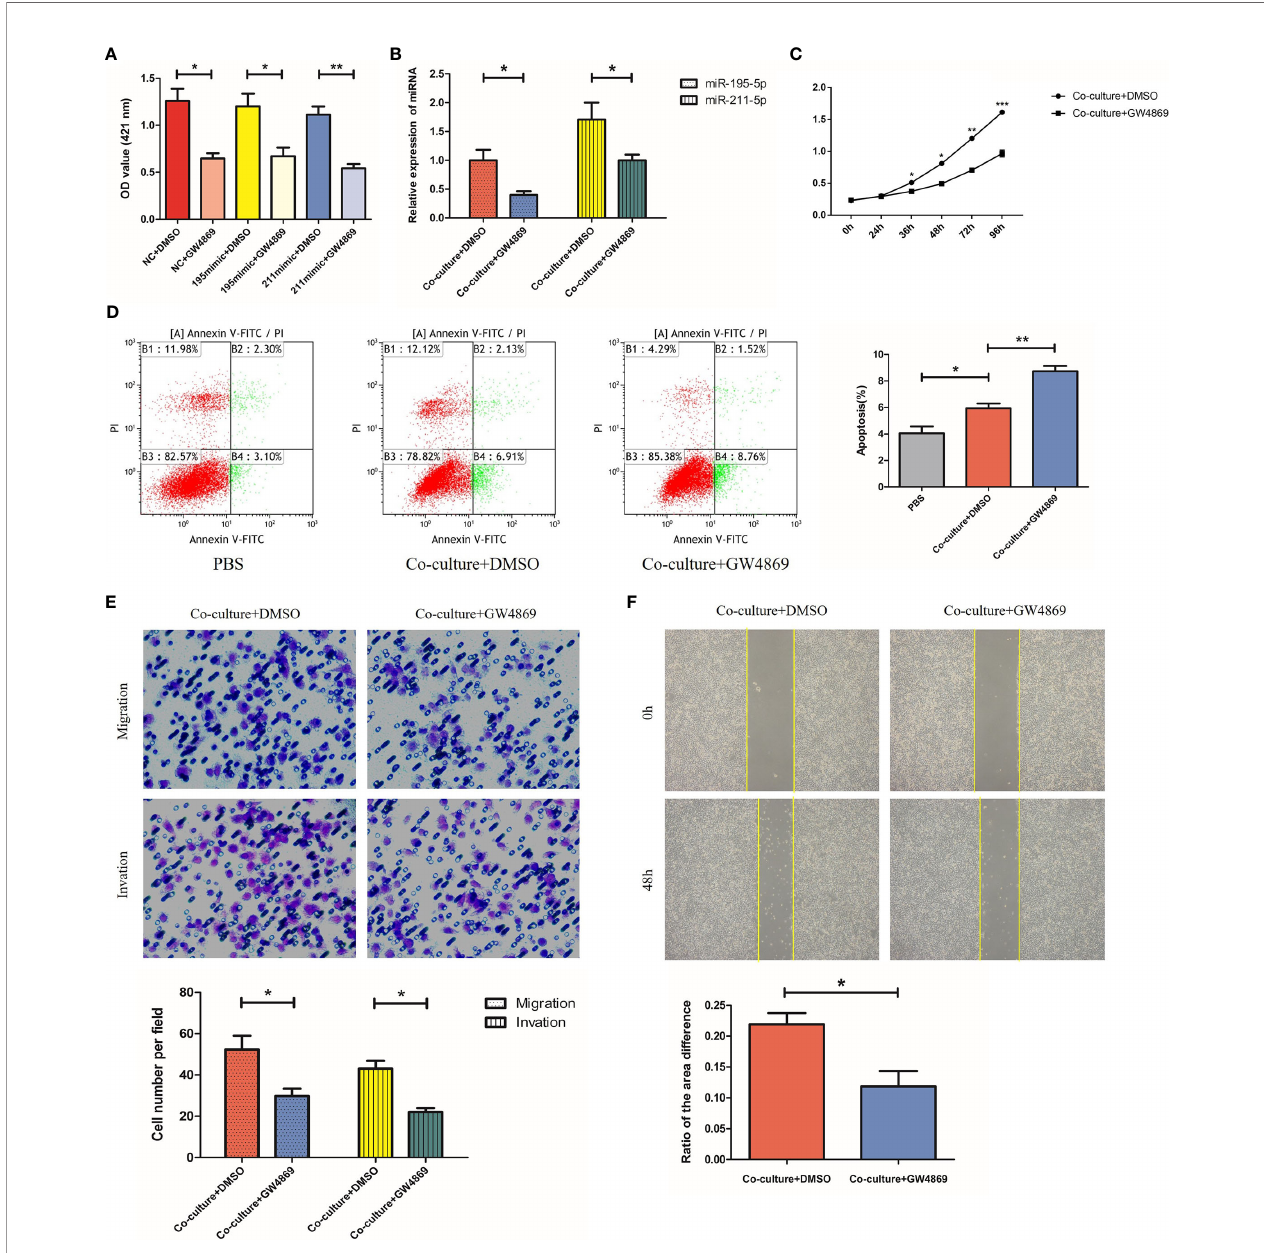
FIGURE 5 | GW4869 inhibits secretion of exosomes from SGC-7901 cells. (A) Release of exosomes from SGC-7901 cells in cells treated with GW4869 or DMSO detected using Ach E activity assay; (B) MiR-195-5p and miR-211-5p expression in 7901 cells treated with or without GW4869 as measured using RT-qPCR; (C – F) . Cell proliferation, apoptosis, migration and invasion of SGC-7901 cells treated with or without GW4869 as measured using CCK-8 assay, fl ow cytometry, transwell and wound healing assay. (*p-value<0.05, **p-value<0.01). The representative images of cells that had proliferated, apoptotic, migrated and had been invaded were shown. Mean ± SEM of three independent experiments are